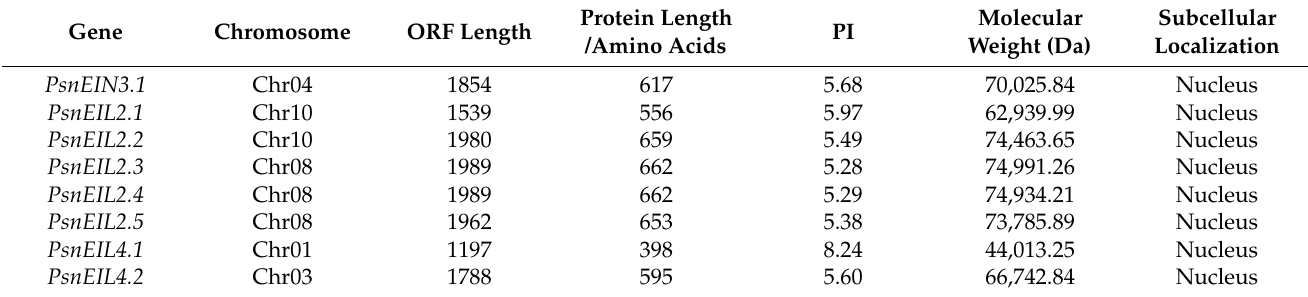
Table 1. Features of the eight PsnEIN3/EIL